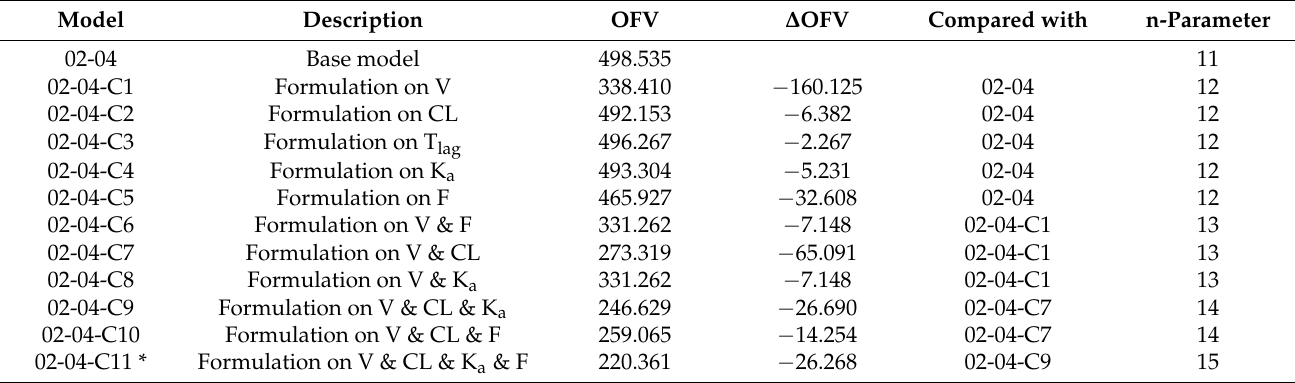
Table 8. Stepwise search for covariates in the models of methotrexate-loaded nanoparticles and nanoemulsions.